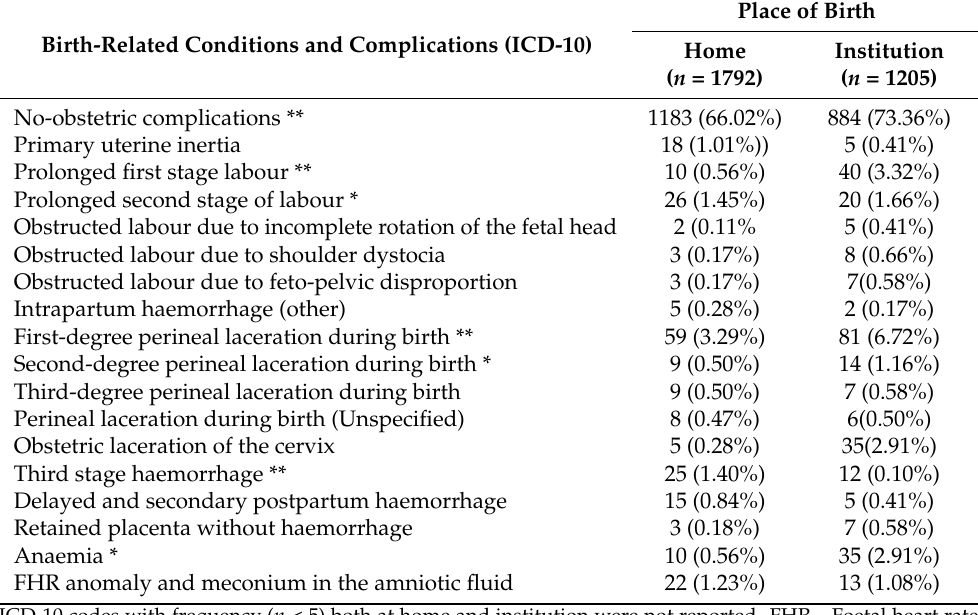
Table 3. Comparisons of maternal and feto-neonatal homebirth and institutional birth-related condi- tions and complications in Hungary,